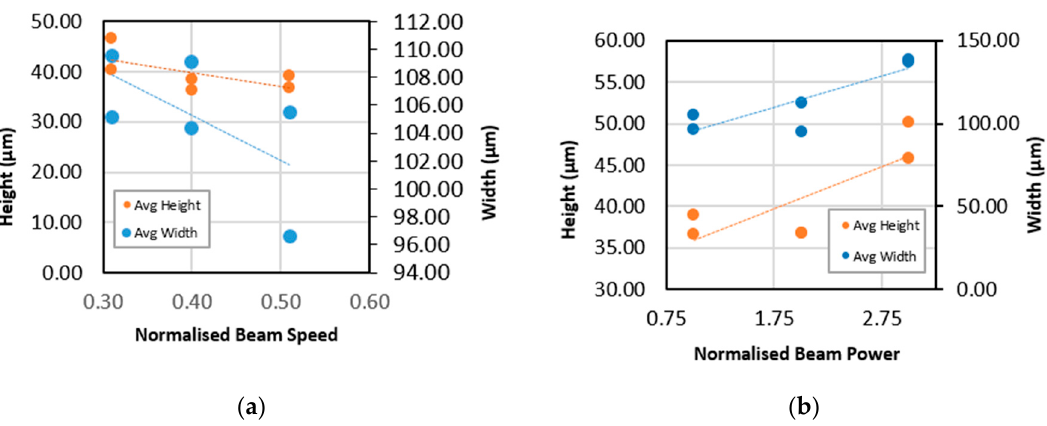
Figure 3. Influence of ( a ) normalised beam speed and ( b ) normalised beam power on melt track size.